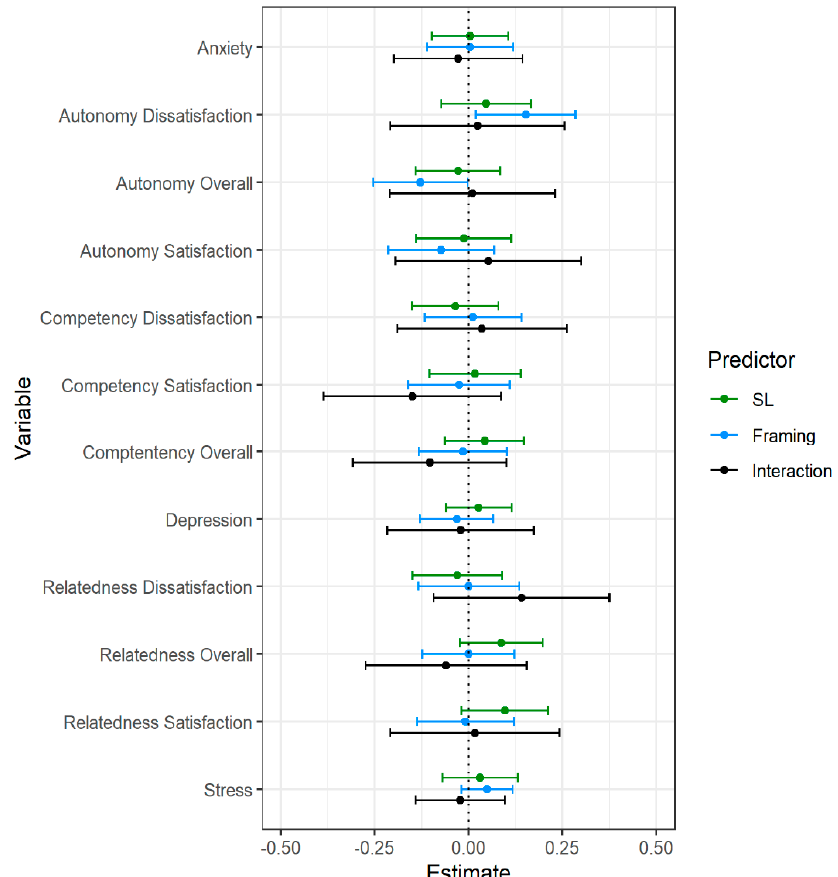
Figure 3. Differences in post-intervention well-being based on Slow-Looking, Immersive Mindset Framing, and Slow-Looking x Framing interaction conditions. Note. Estimates represent regression weights (controlling for pre-intervention well-being) in pre-intervention standard deviation units. Error bars represent 95% confidence intervals.